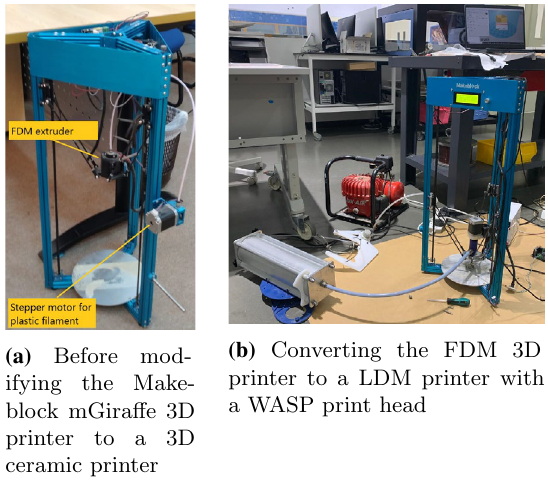
Fig. 6 Converting a polymer FDM 3D printer to handle ceramic